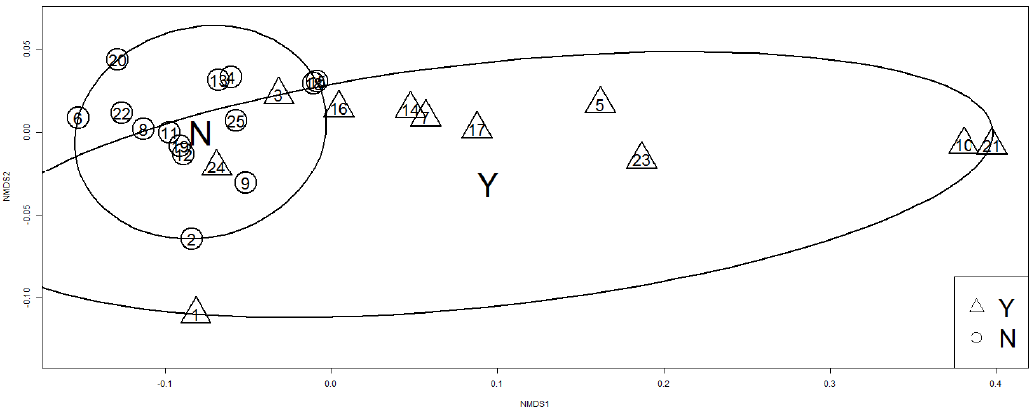
Figure 5. Non-metric multidimensional scaling visualizing the level of similarity for factor smoke. N, no; Y, yes.